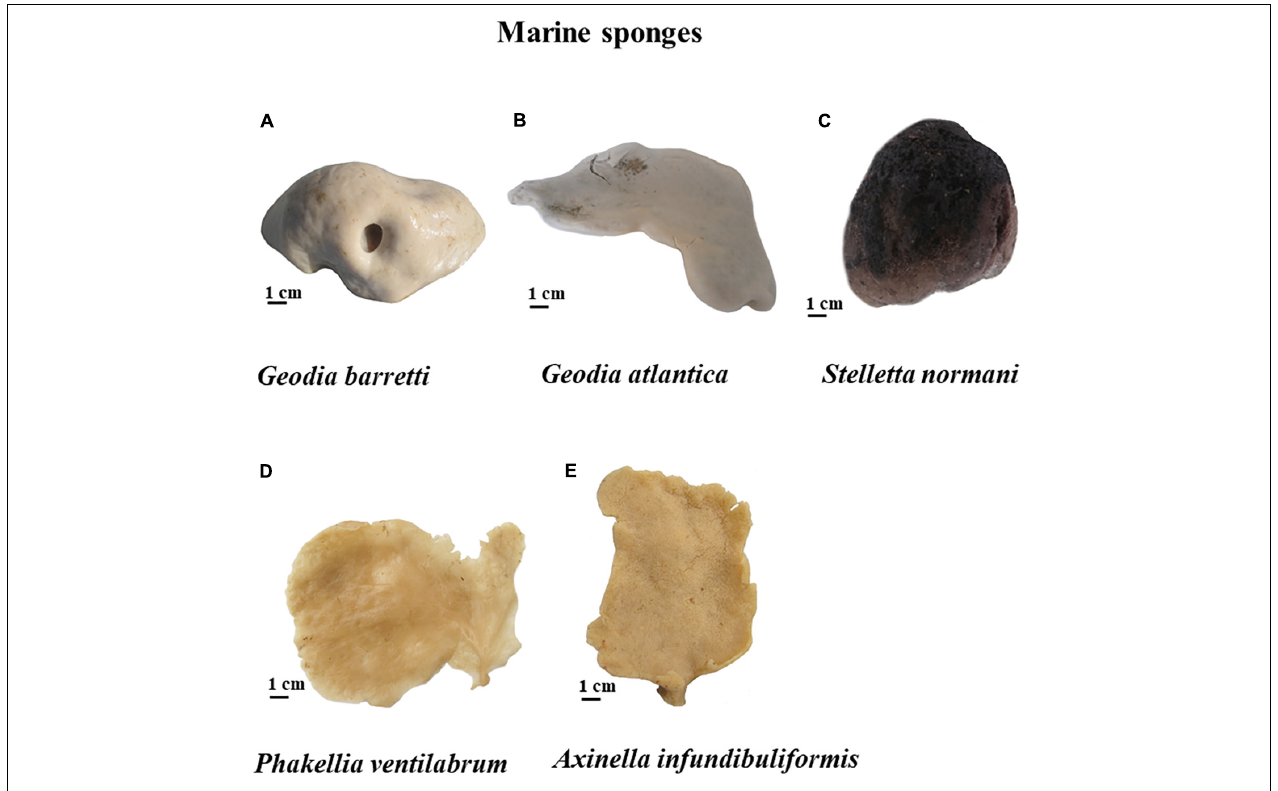
FIGURE 2 | Five marine sponges studied of North Atlantic, namely G. barretti (A) , G. atlantica (B) and S. normani (C) , P. ventilabrum (D) , and A. infundibuliformis (E) . TABLE 1 | Stations and sponge species in which Geodia barretti (Gb), Geodia atlantica (Ga), Stelletta normani (Sn), Phakellia ventilabrum (Pv), and Axinella infundibuliformis (Ai) were recovered. Species Station Start lat. Start long. Start depth (m) End lat. End long. End depth